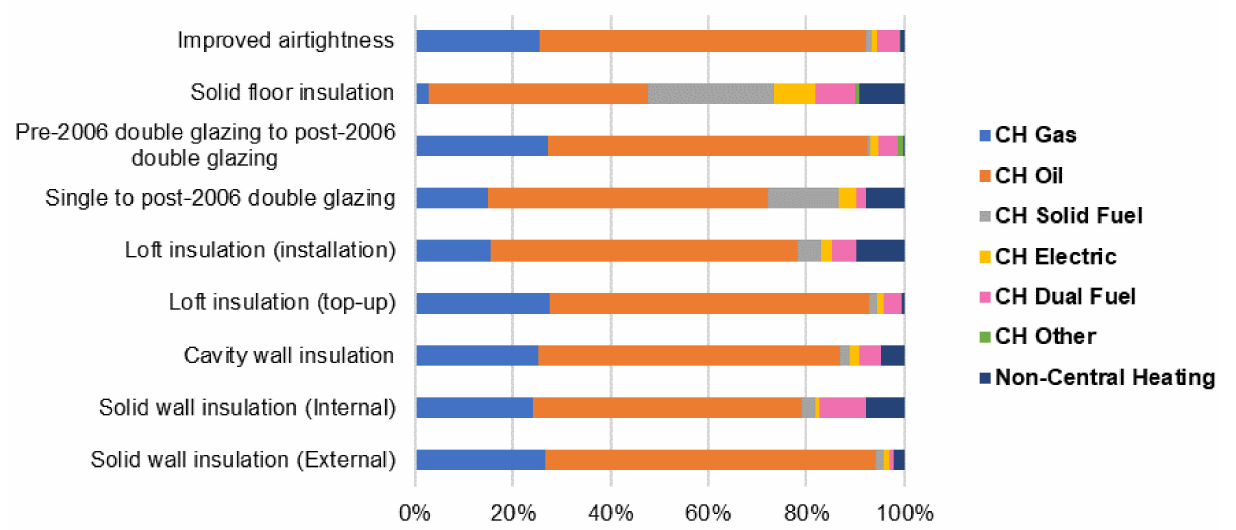
Figure 2. Heating fuel shares among houses requiring different retrofit